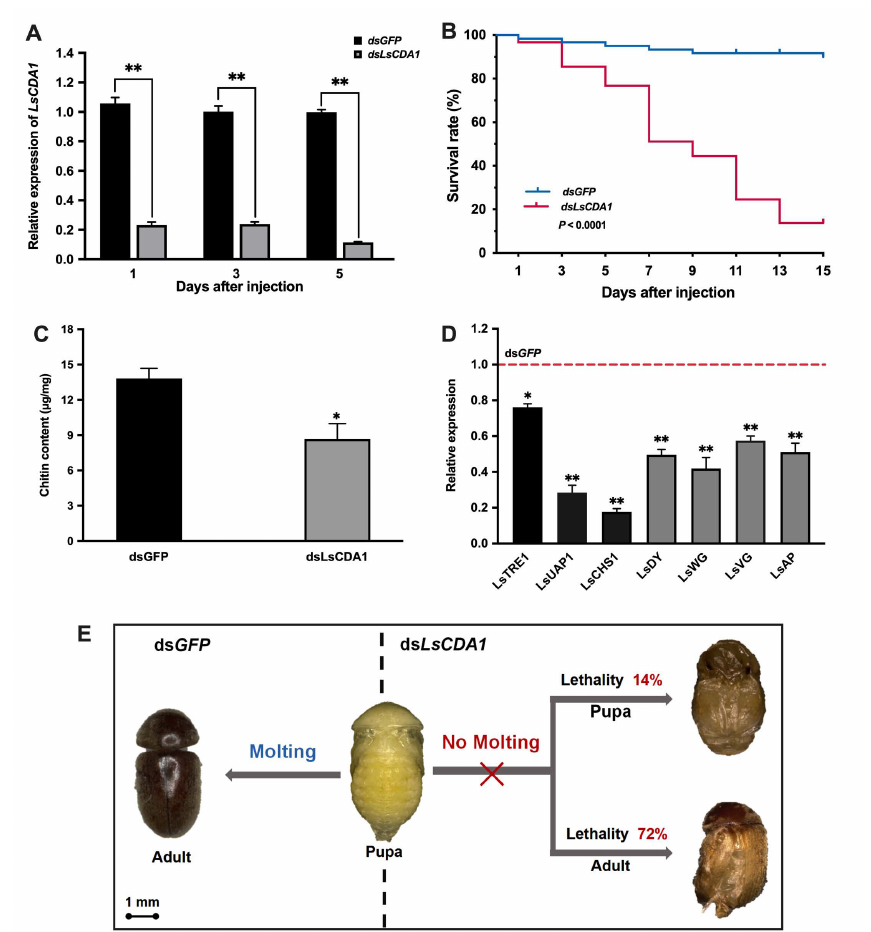
Figure 6. The e ff ect of LsCDA1 knockdown on pupal–adult metamorphosis in L. serricorne . ( A ) The relative expression levels of LsCDA1 at 1, 3, and 5 days after LsCDA1 or GFP dsRNA injection at the late pupal stage. ( B ) Kaplan-Meier survival curves of L. serricorne pupae after LsCDA1 or GFP dsRNA injection. The e ff ects of LsCDA1 knockdown on chitin contents ( C ) and the expressions of three chitin synthesis pathway genes and four genes involved in wing development ( D ). The expression values were calculated by comparison to the ds GFP group, which was normalized at 1. ( E ) Representative phenotypes of pupae after LsCDA1 or GFP dsRNA injection. Significant di ff erences between the RNAi group and the control group were determined using by Student’s t -test (* p < 0.05, ** p <